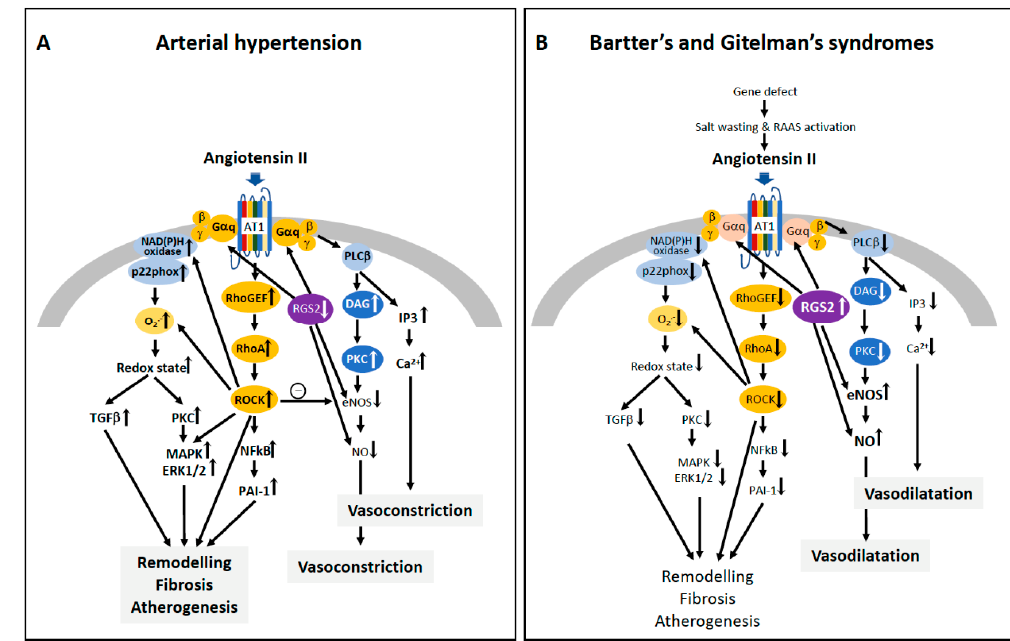
Figure 3. Schematic representation of Angiotensin II-mediated pathways involving RhoA/ROCK in arterial hypertension ( A ) and Bartter’s and Gitelman’s syndromes ( B ). Angiotensin II, via angiotensin